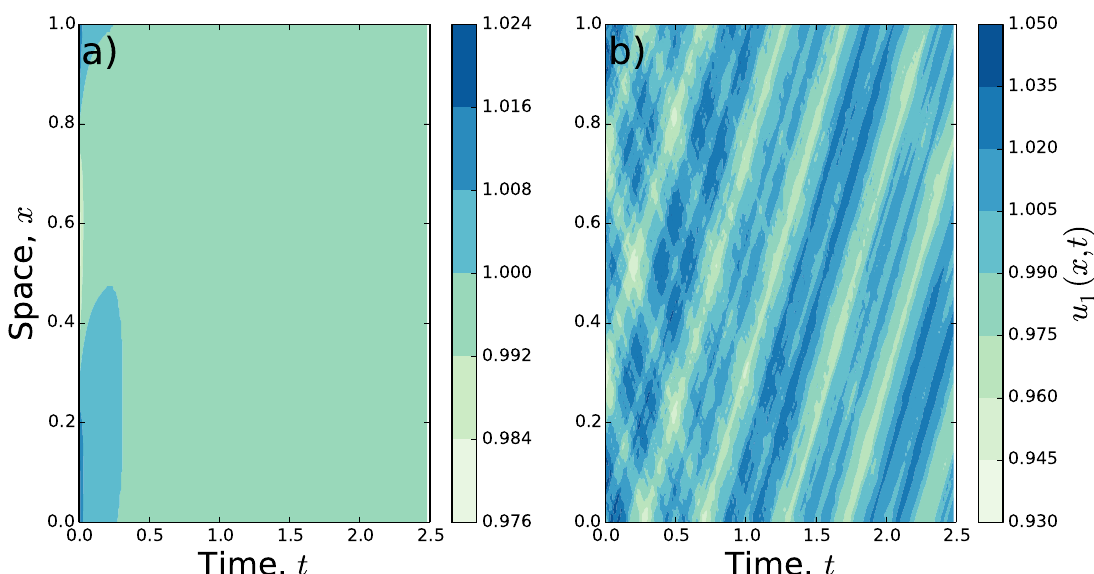
Figure 2. Example numerics for N = 2 . Numerical solutions of Equation (1) for N = 2, d 2 = 1, γ 12 = 1, γ 21 = − 1, and K ( x ) as in Equation (14) with σ = 0.1. Both examples have random continuous initial conditions, but forced to be symmetric about x = 0.5 to satisfy periodic boundary conditions. In Panel ( a ), T = 0, and the initial perturbation of the constant steady state decays to the solution u 1 ( x , ∞ ) = 1. In Panel ( b ), T = 1. Here, the population u 1 moves across the landscape, not settling to